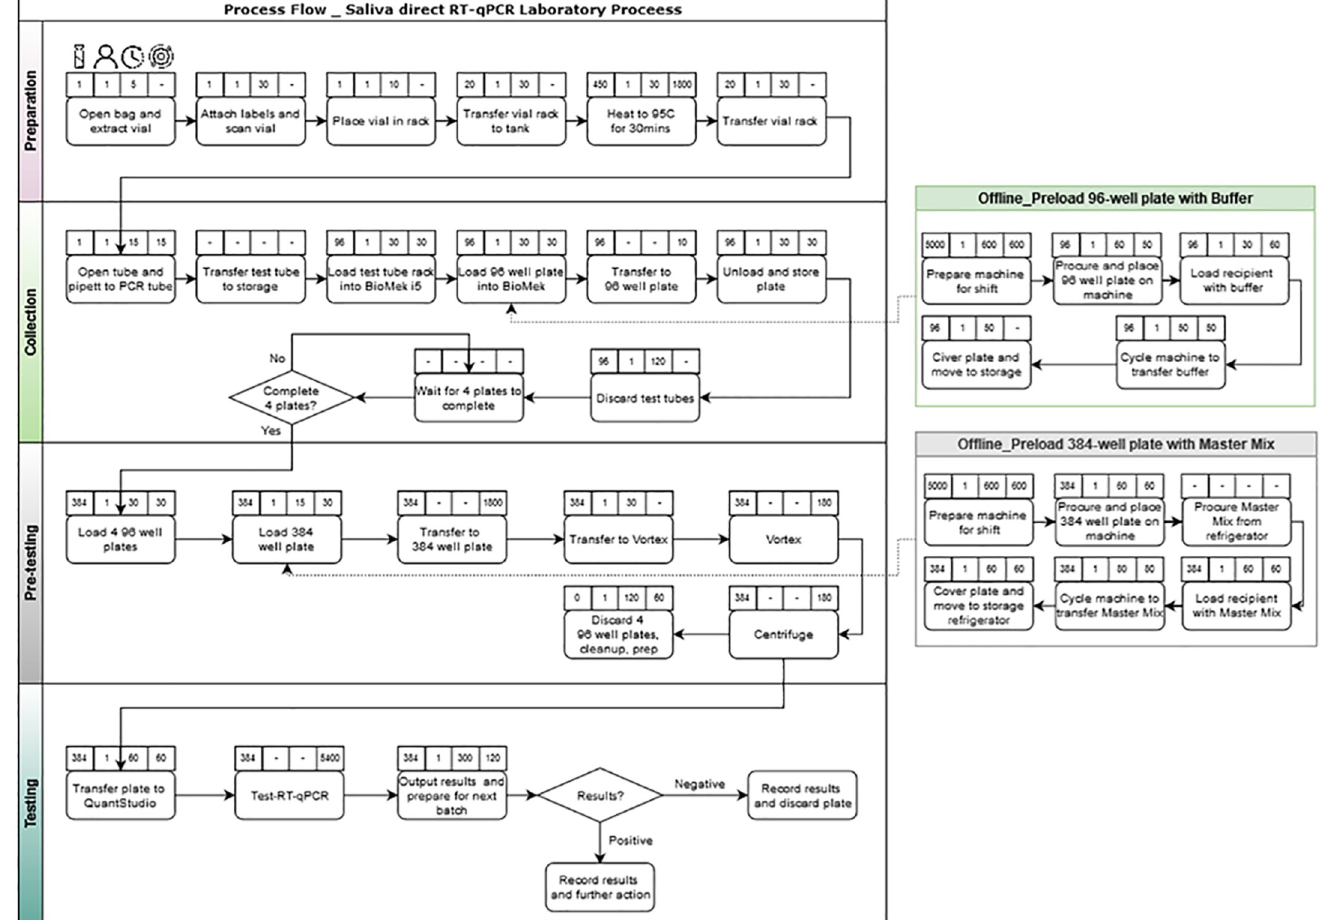
PLOS ONE | https://doi.org/10.1371/journal.pone.0253869 June 29,